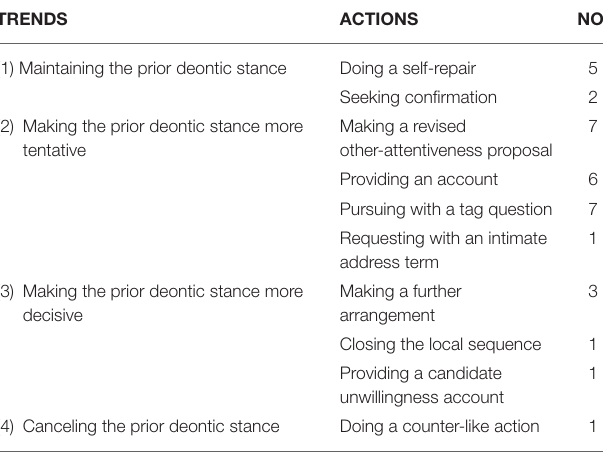
TABLE 1 | Deontic trends and subsequent actions in proposal sequences.